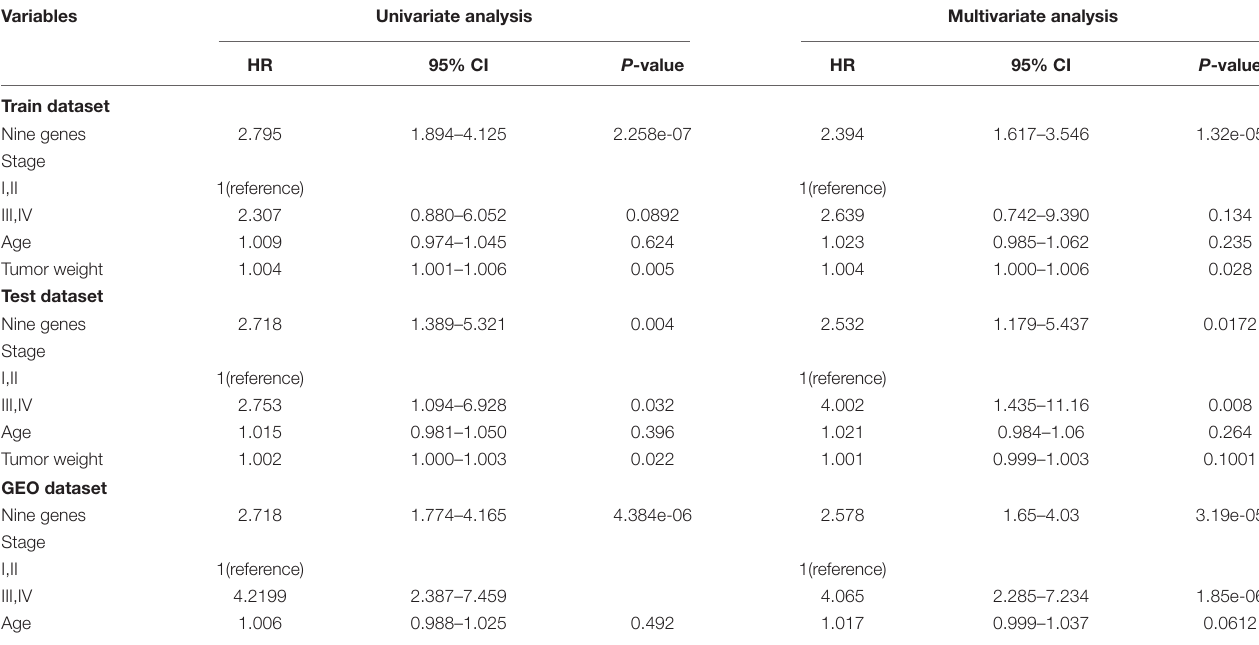
TABLE 1 | Univariate and multivariate Cox regression analysis in the